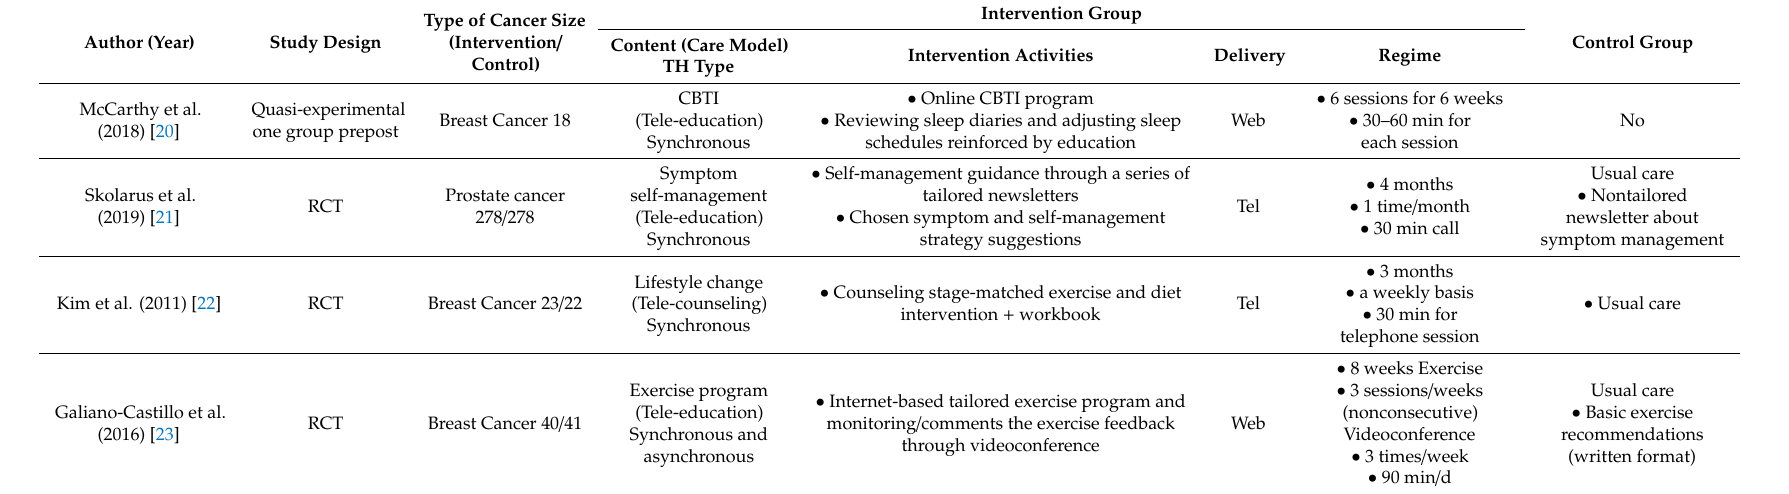
Table 2. Summary of studies investigating the use of TH in the scope of OT